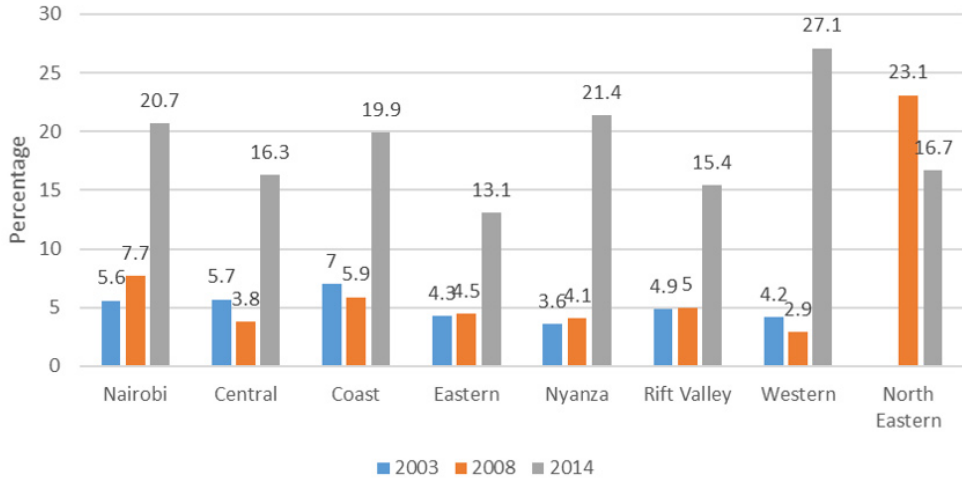
Figure 7. Percentage use of implants among modern contraceptives by region, 2003–2014.